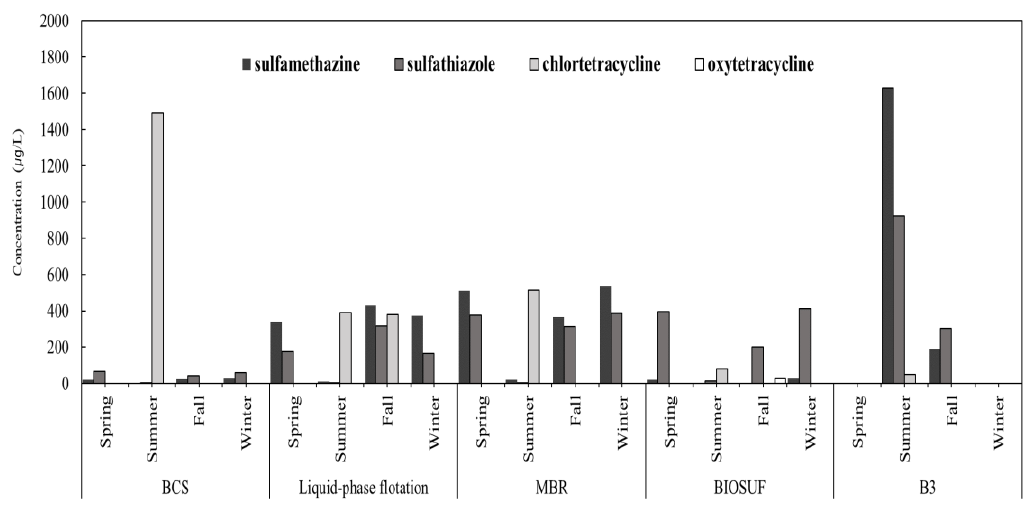
Figure 2. Seasonal antibiotic concentrations detected in influents from targeted livestock wastewater treatment plants (no data in spring and winter at B3). BCS: bio-ceramic sequencing batch reactor, MBR: membrane bioreactor, BIOSUF: bioreactor and ultrafiltration, and B3: Biobest Bacillus .